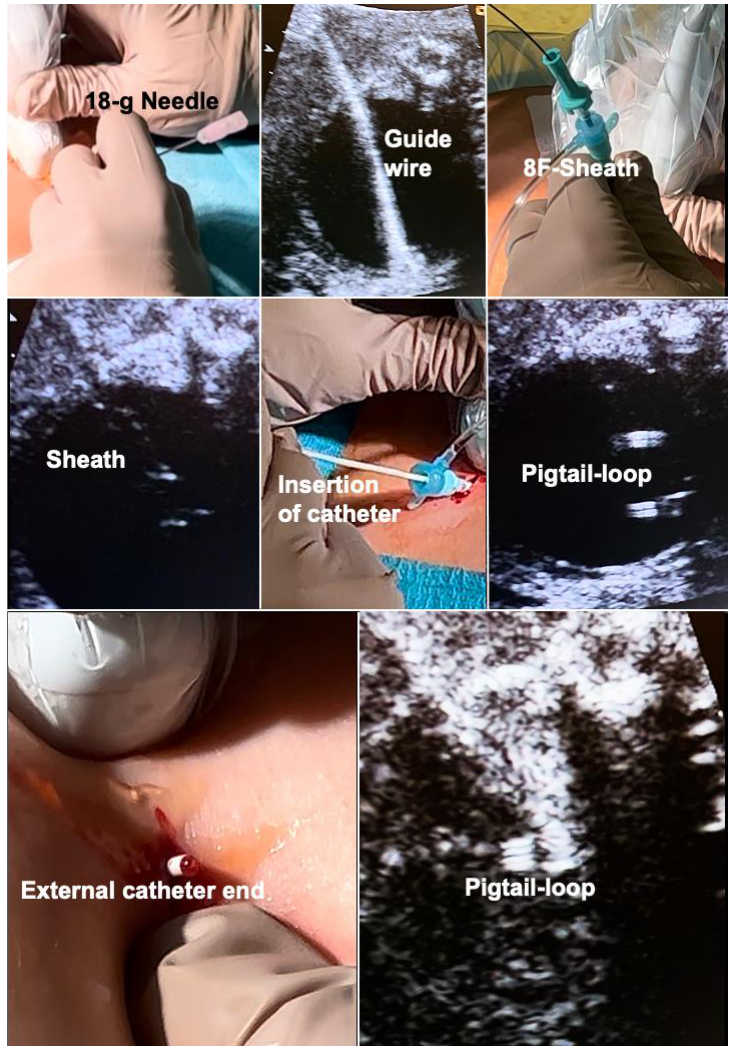
Figure 7. Novel shunt technique for fetuses with megacystis from lower urinary tract obstruction (LUTO) in order to achieve safe, early second trimester shunting. Top left — after a small skin incision, percutaneous ultrasound-guided puncture of the fetal bladder with an 18-gauge needle is performed. Top center — this is followed by insertion of a 0.035 ′′ -guide wire via the needle shaft into the fetal bladder and — top right — insertion of an 8F-sheath — over the wire — into the fetal bladder. Middle left — the tip of the sheath can be seen inside the bladder. Middle center — A single-pigtail catheter has been mounted on the trocar of an 18-gauge needle and is being inserted via the sheath into the fetal bladder. Middle right — after removal of the needle trocar, the pigtail loop becomes visible. Bottom left — after removal of the 8F-sheath, fetal urine drips from the distal end of the catheter. Then, the catheter end is pushed below the skin level of the maternal abdomen and the skin incision is closed with a suture. Bottom right — ultrasound imaging after the procedure demonstrates the pigtail loop within the empty bladder.